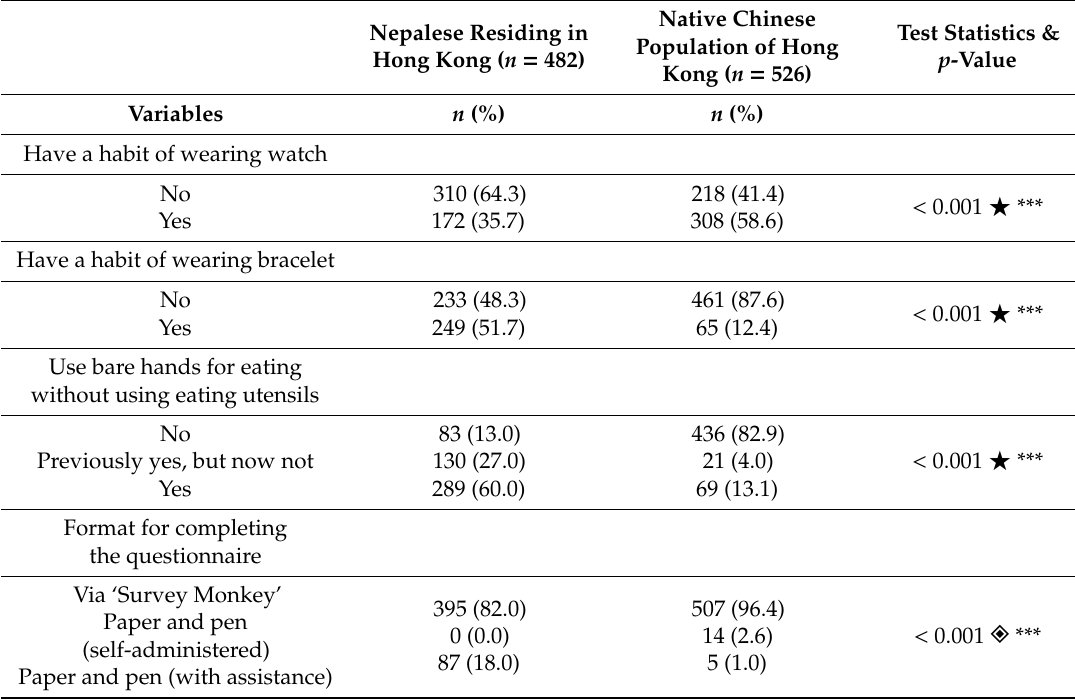
Table 2. Knowledge level on hand hygiene (0 to 12).